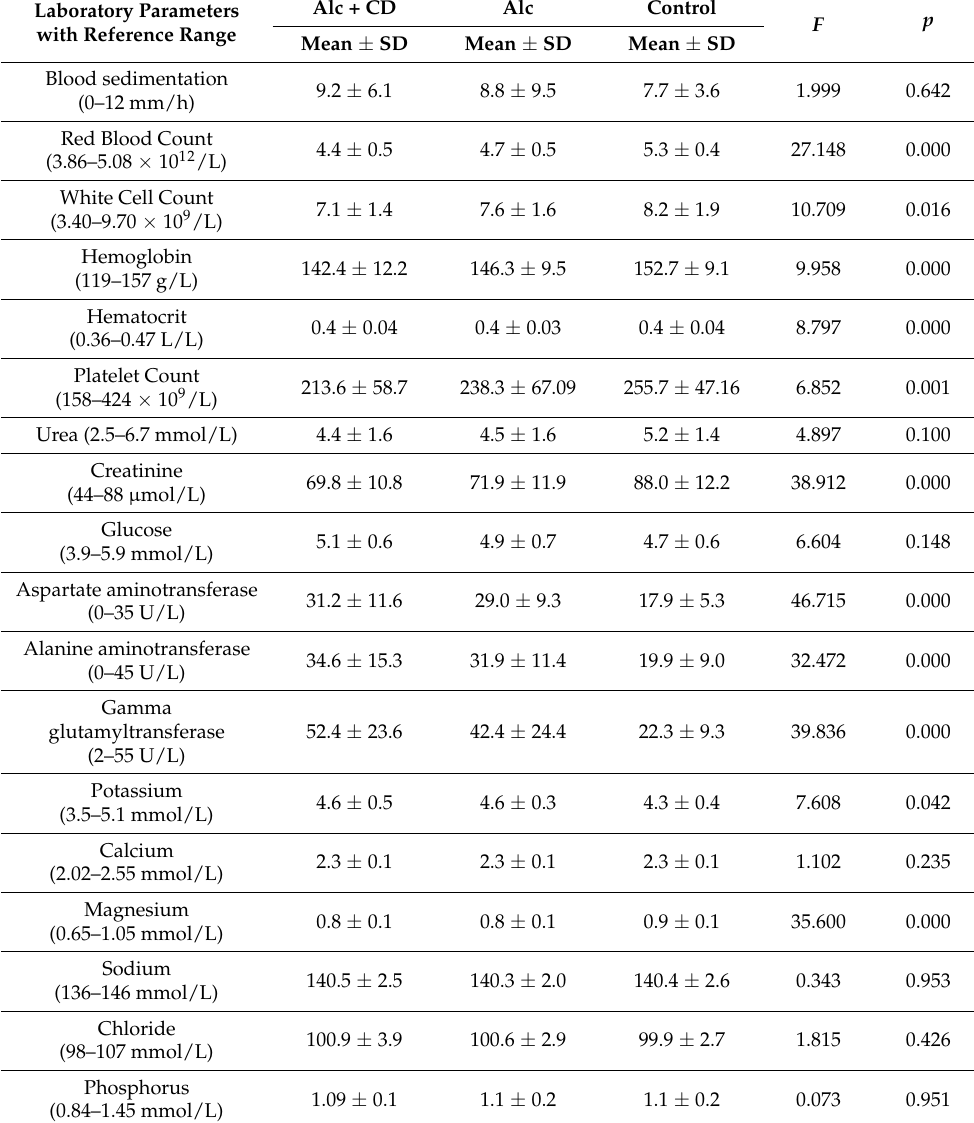
Table 2. Laboratory parameters of the